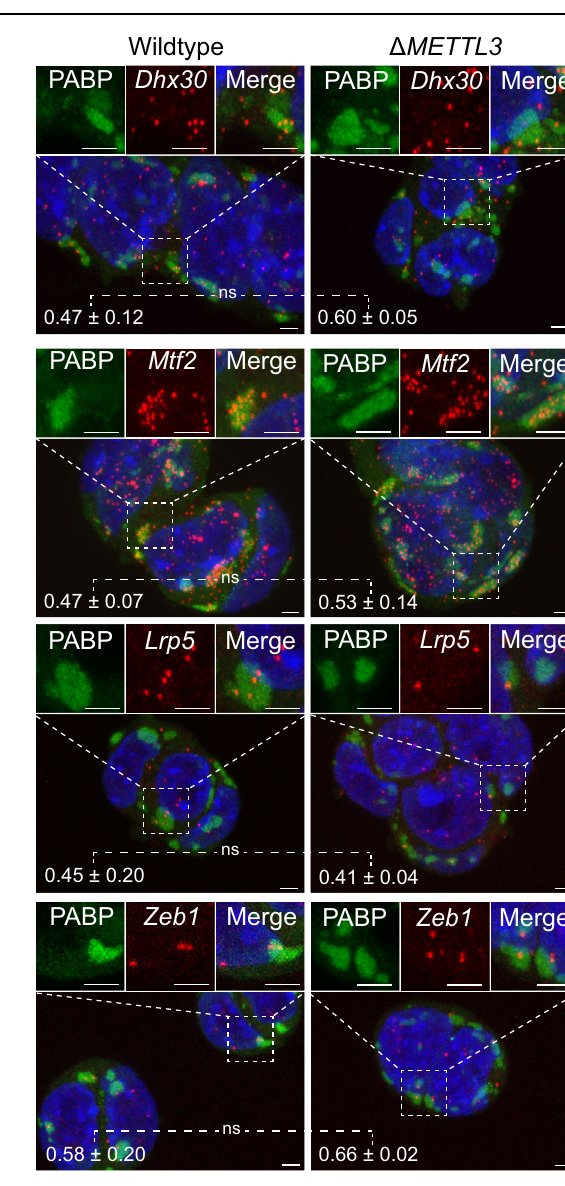
Fig. 1 There is no difference in the fraction of polymethylated m 6 A mRNAs in arsenite-induced stress granules between wildtype and Δ METTL3 mES cells. Representative images of wildtype and Δ METTL3 mES cells stressed for 1 h with arsenite and costained with single-molecule FISH probes against Bahcc1, Dhx30, Tnrc6c, Mtf2, Aff1, Lrp5, Rictor, and Zeb1 (red) and antibody against PABP protein (green). The nuclei are stained with DAPI (blue). Scale bar is 1 µ M. Standard deviations are derived from three biological replicates. ns denotes not signi fi cant respectively (unpaired two-tailed Student's t test, P > 0.05). Source data are provided for this Figure (see data